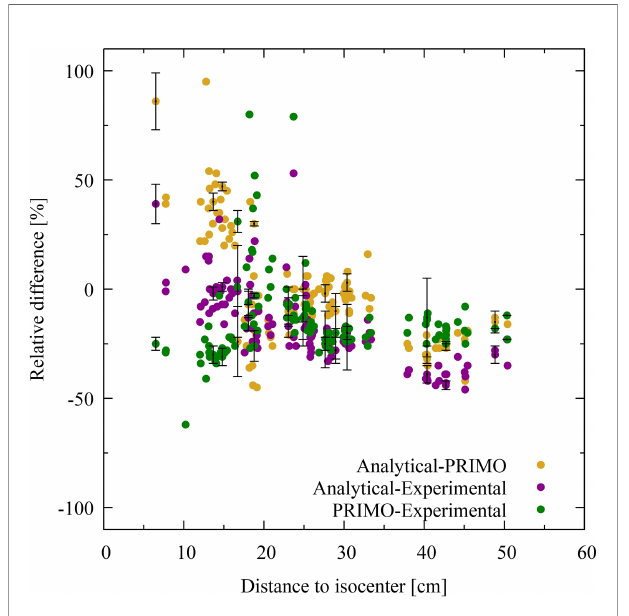
FIGURE 4 | Dose difference for intensity-modulated radiotherapy in percentage for each thermoluminescent dosimeter (TLD) position given with respect to the distance to the isocenter. The difference between PRIMO and analytical data is represented with brown dots, and the PRIMO data set is taken as the reference. The comparison between experimental and analytical data is shown with purple dots and between experimental and PRIMO data with green dots. In these cases, the experimental data is taken as the reference data set. For visual clarity, statistical uncertainty bars ( k = 2) are shown for every twentieth TLD position.